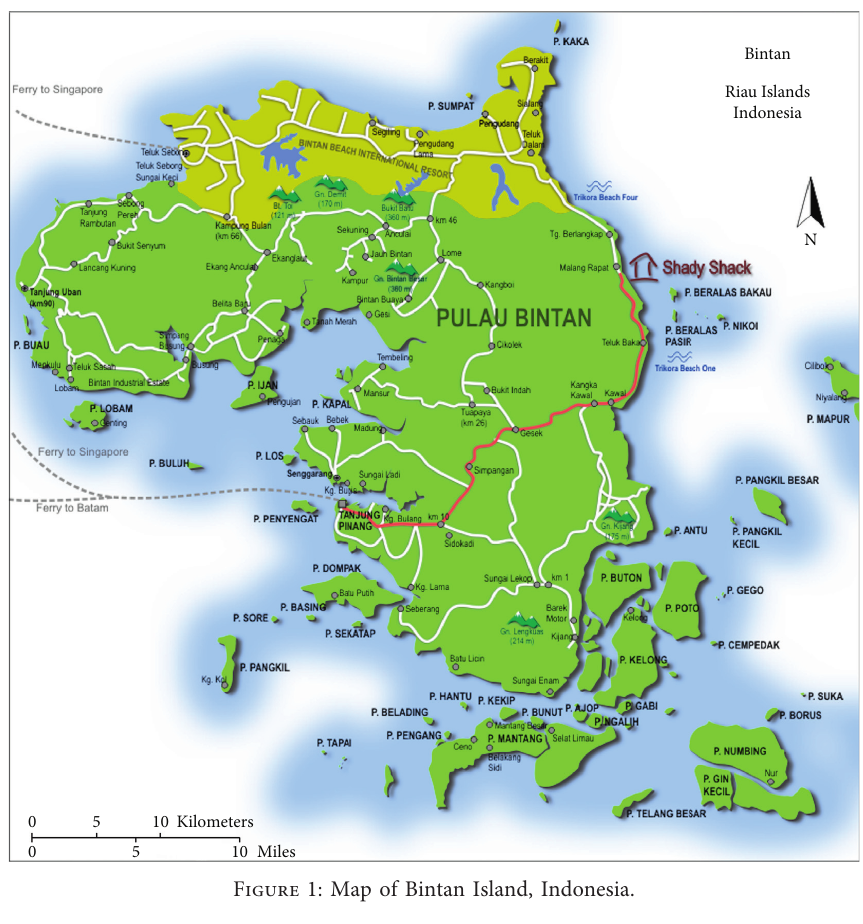
Figure 1: Map of Bintan Island, Indonesia.